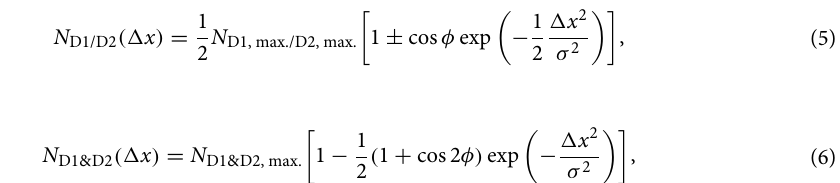
1 ) as a function of +